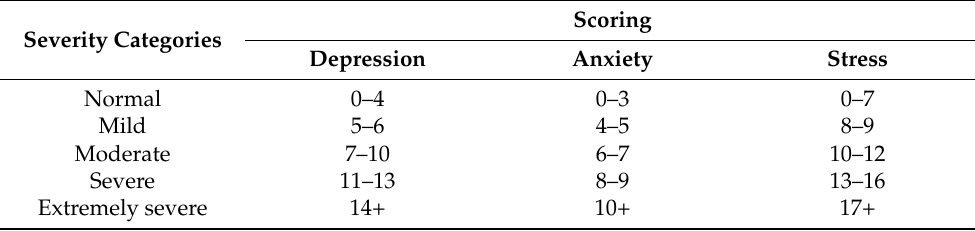
Table 2. Scoring of psychological well-being